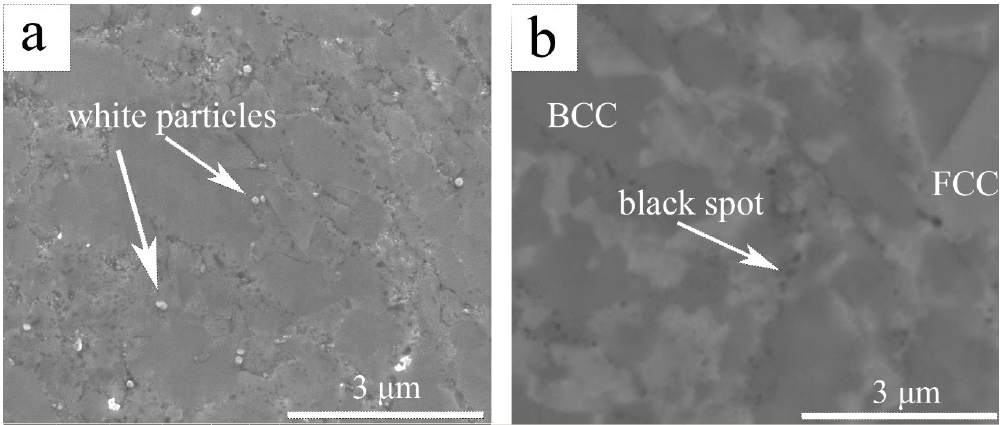
Figure 2. ( a ) Scanning electron (SE) and ( b ) backscattered electron (BSE) images of the microstructures of the SPSed HEA.